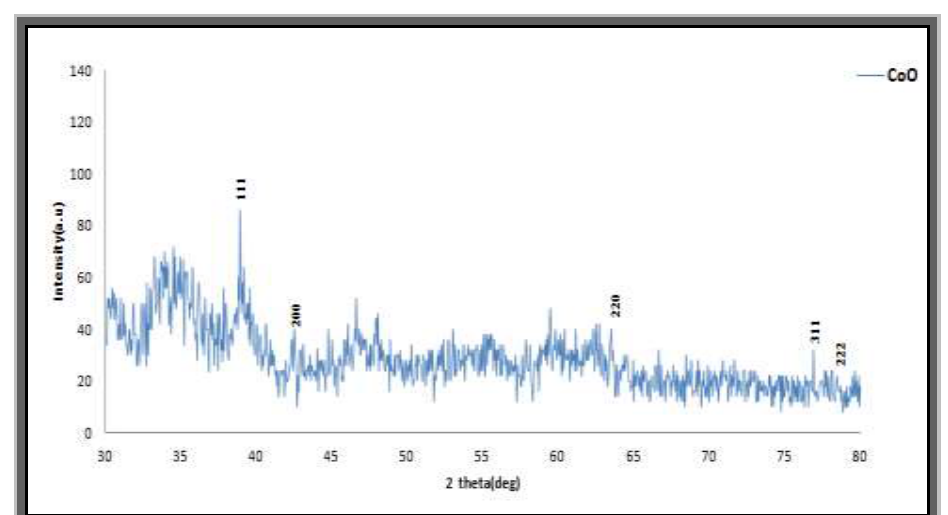
Fig. 4: Patterns of XRD for CoO powder.